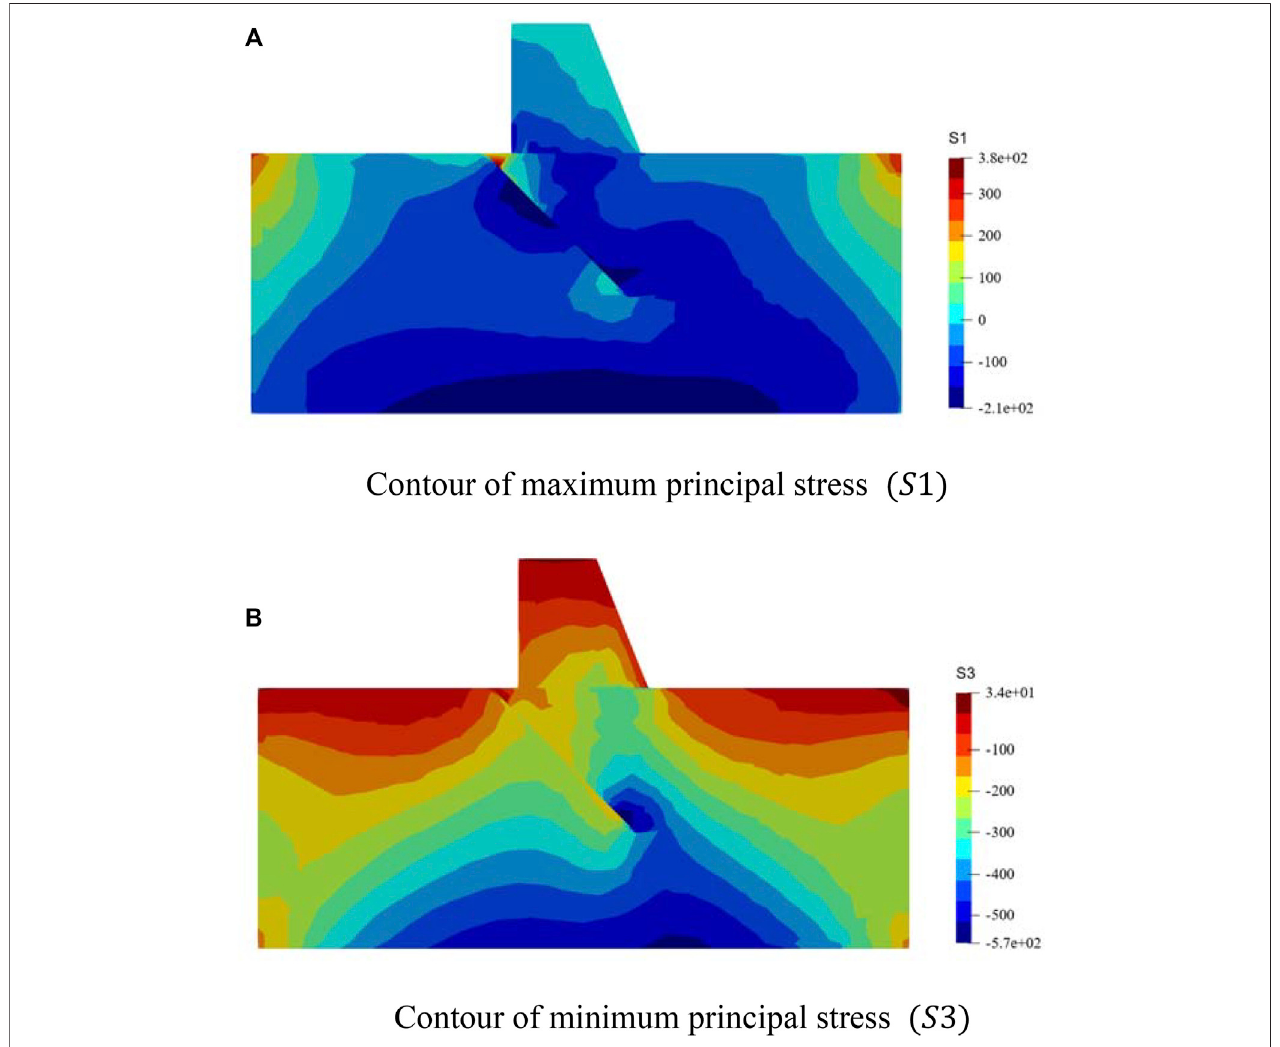
FIGURE 14 | The contours of maximum principal stress ( S 1 is the maximum principal stress and minimum principal stress) ( S 3 is the minimum principal stress) .